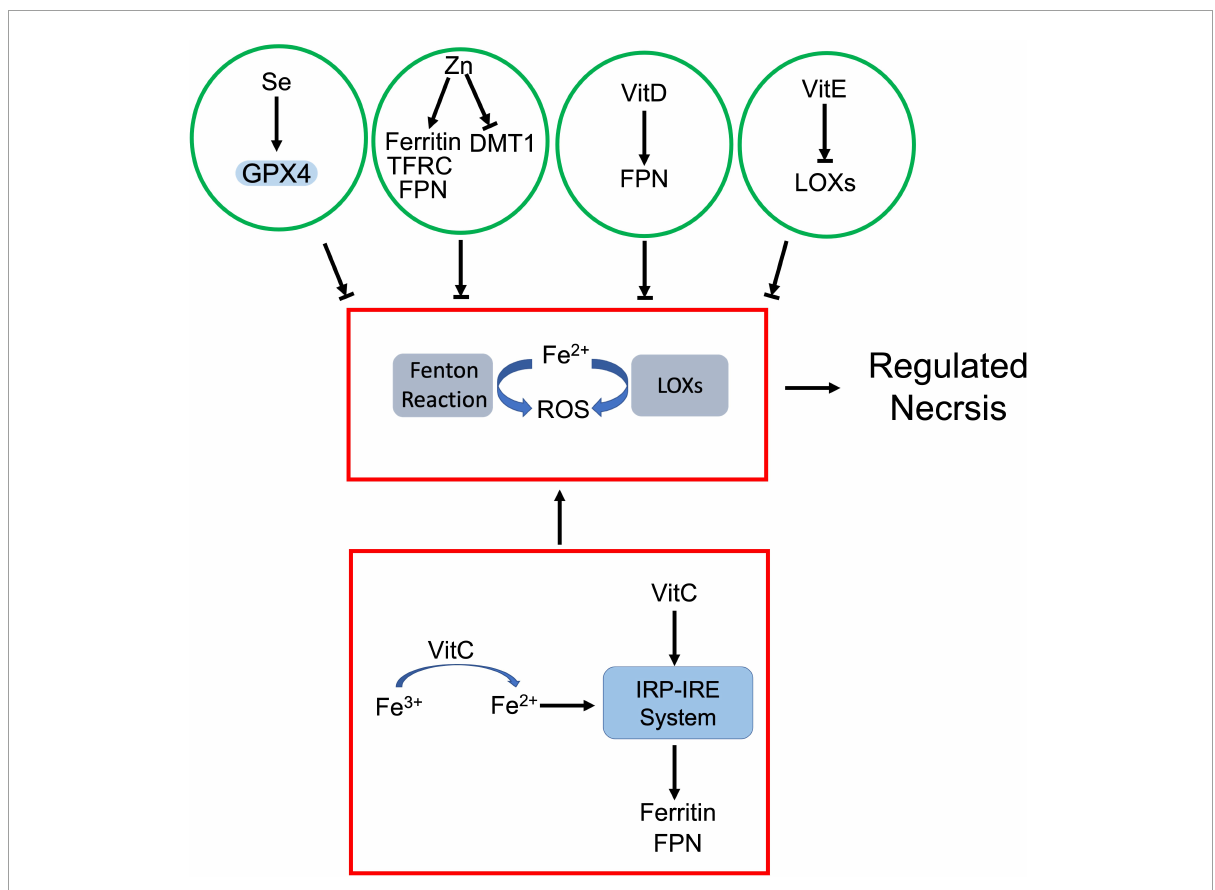
FIGURE6 Crosstalk between prooxidant and antioxidant micronutrients in regulated necrosis process. Iron, as a prooxidant, catalyzes generation of ROS via Fenton reaction and LOXs. The antioxidant micronutrients counteract iron-mediated ROS production. Among them, selenium (Se) enhances GPX4 activity, and vitamin E (VitE) inhibits the activity of LOXs. Zinc (Zn) and vitamin D (VitD) attenuate iron-dependent ROS by modulating iron metabolism associated proteins. On the other hand, vitamin C (VitC) not only facilitates reduction of iron ion, but also upregulates iron metabolism associated proteins via IRP-IRE system, which jointly increase the cellular uptake of